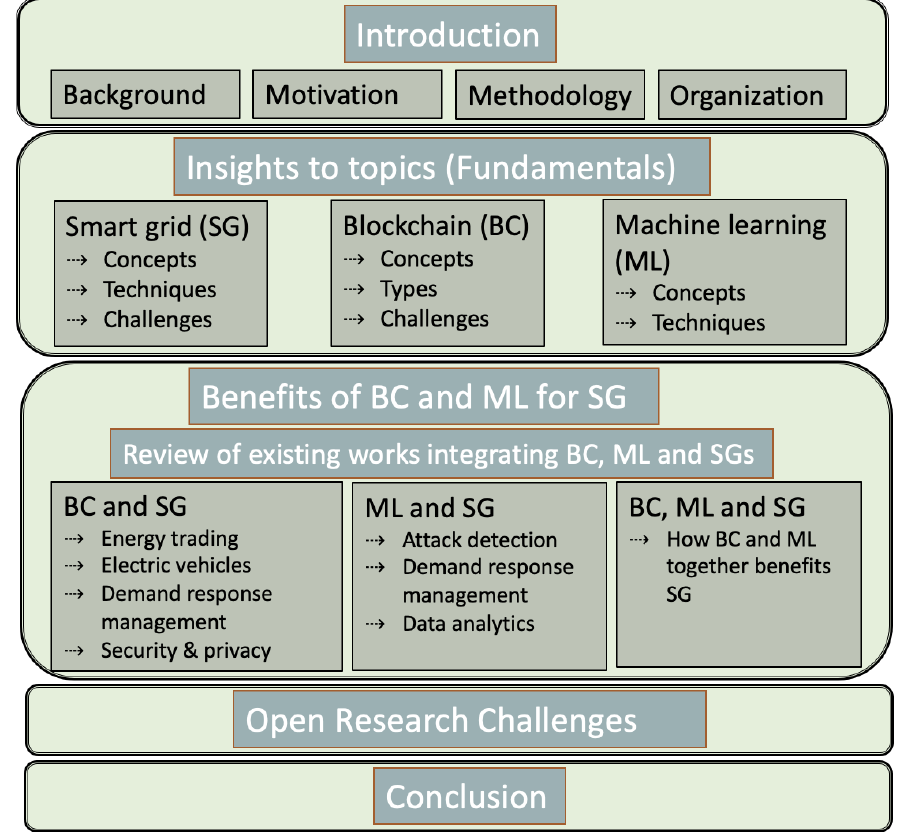
Figure 2. Outline of the